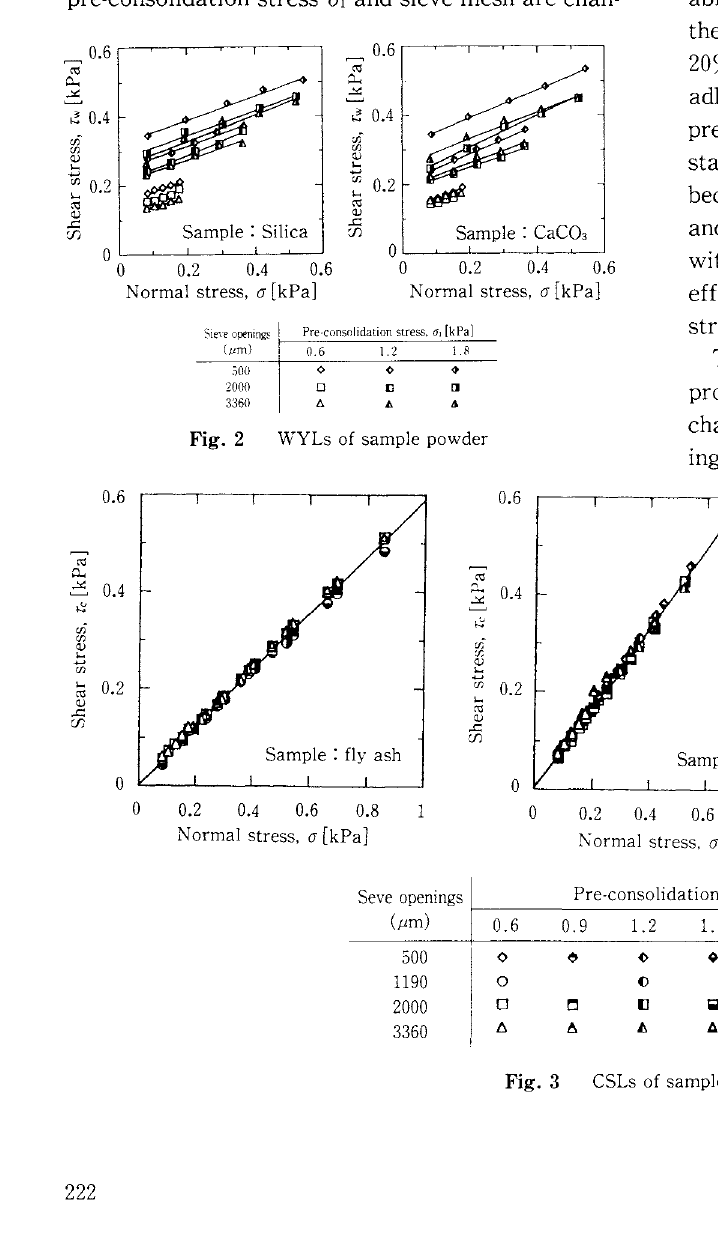
Fig. 3 CSLs of sample